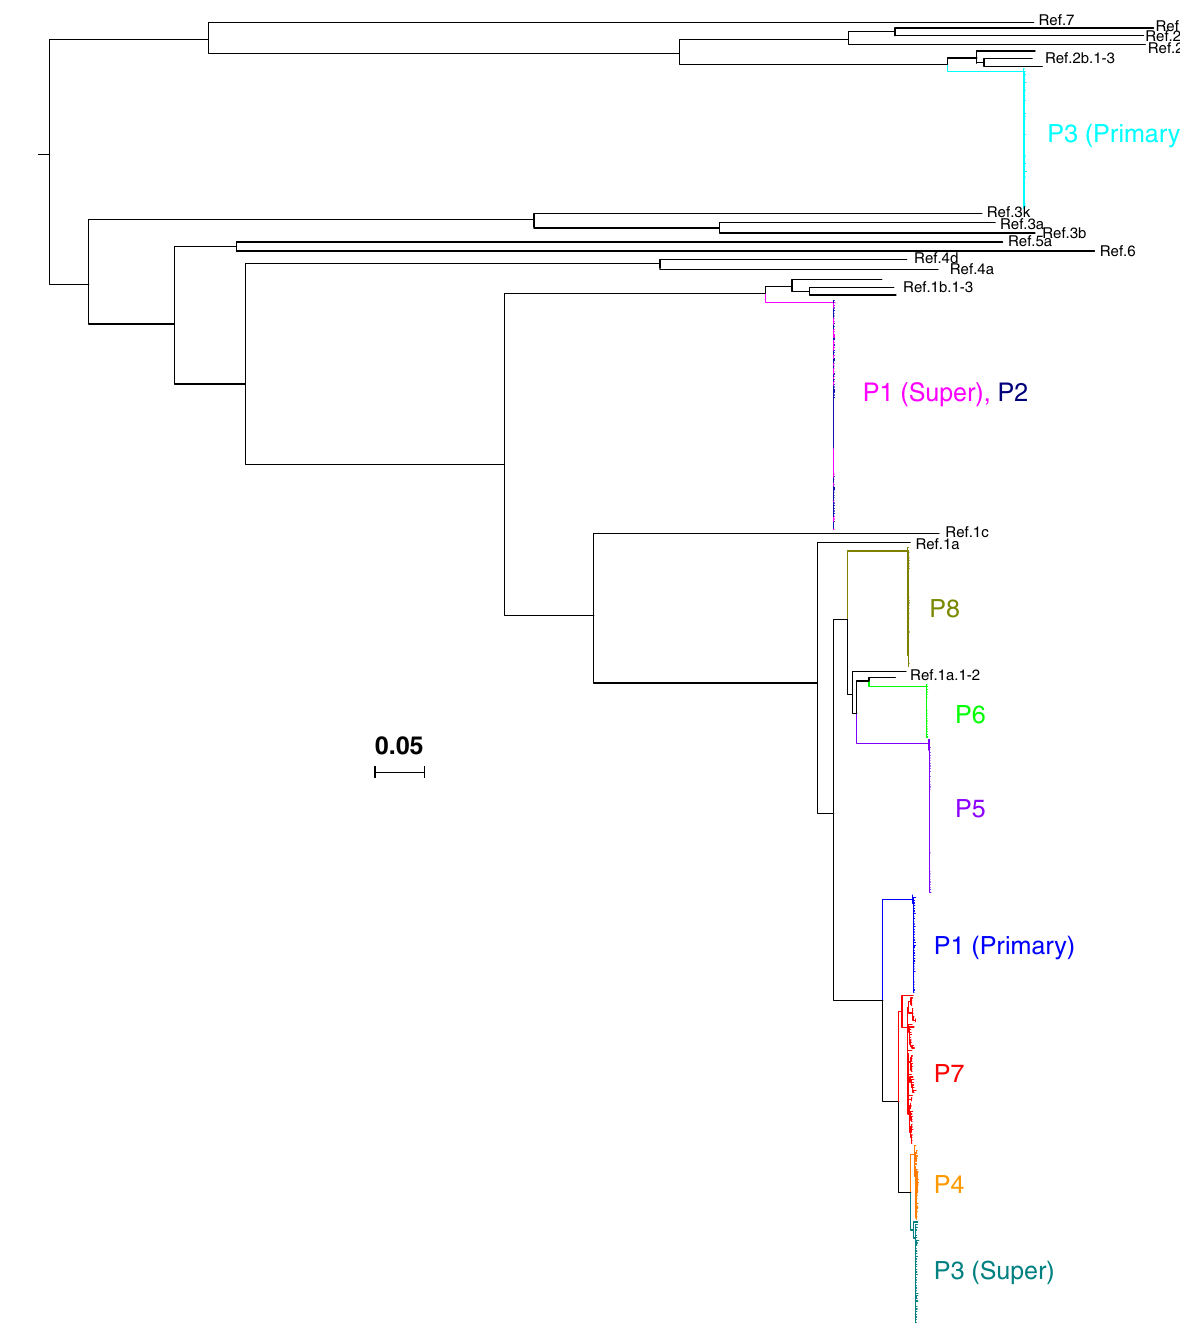
Fig 2. Maximum-likelihood tree of HCV sequences during acute and early hepatitis C virus (HCV) among eight HIV-infected men who have sex with men. 5’ half genome sequences corresponding to core, E1E2, p7, NS2, and NS3 genes derived from 10 HCV infections from eight participants are shown along with HCV genotype 1 to 7 reference sequences (black). Two participants (P1 and P3) had both primary and superinfections. P1 (super) and P2 are an epidemiologically linked transmission pair. The sequences from each infection was highlighted with different color. The horizontal scale bar indicates 5% diversity. P, participant; Ref.,